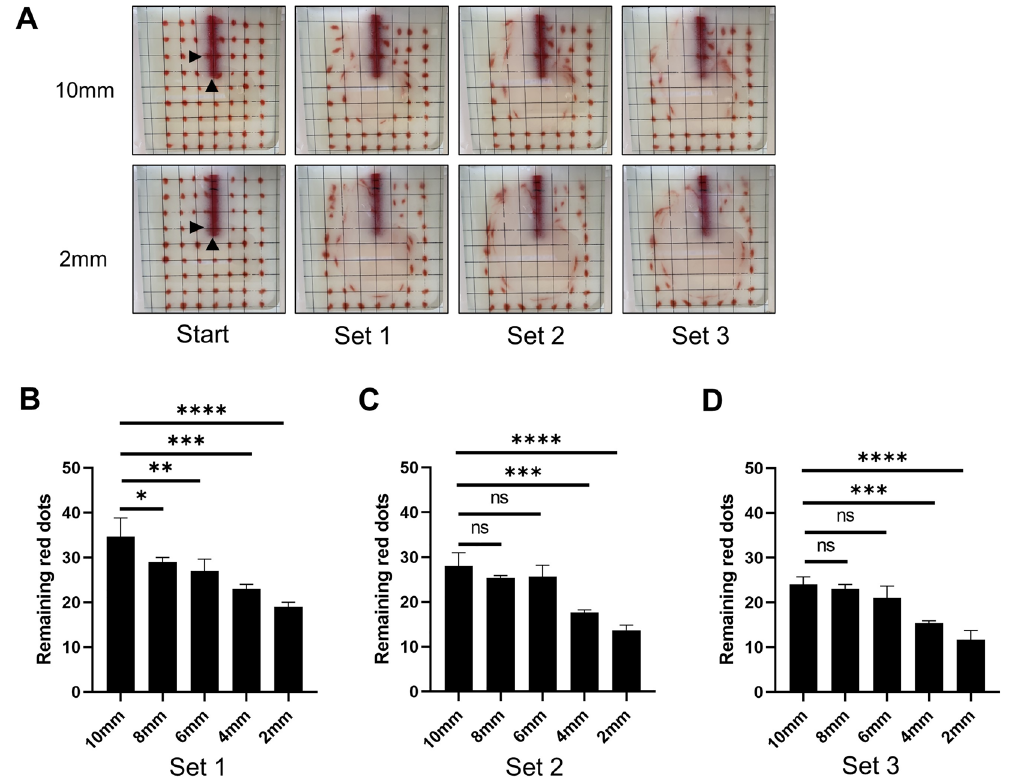
Figure 6. Flow visualization. Modified NC with side holes made at 2, 4, 6, 8, or 10 mm from the tips were used. ( A ) Red dots were drawn on the inside of the front wall of the container to match the intersections of the grid. Images before and after each set using the modified NC with side holes at 2 or 10 mm from the tips under 20 mm/s are shown. Black arrows indicate the location of each hole. ( B – D ) The number of red dots remained in the original position were compared between modified NCs after each